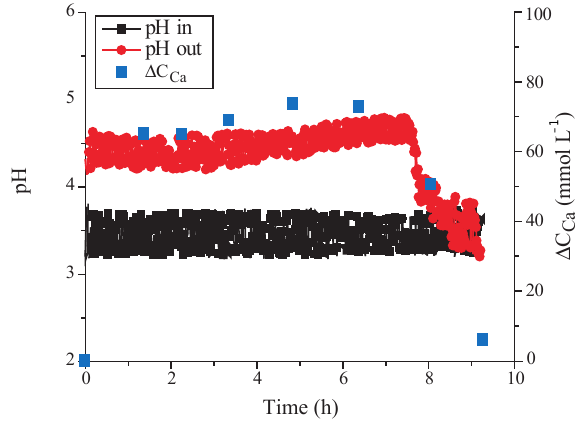
Figure 2. Inlet (black) and outlet (red) pH variation during the percolation experiment as well as variation in calcium concentra-